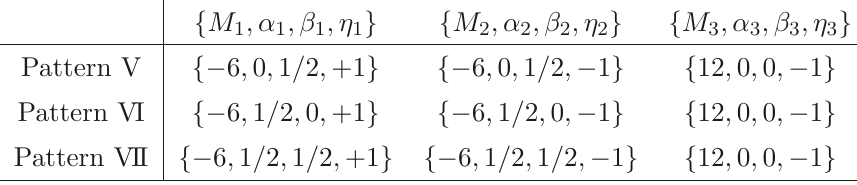
Table 4 . The other samples of